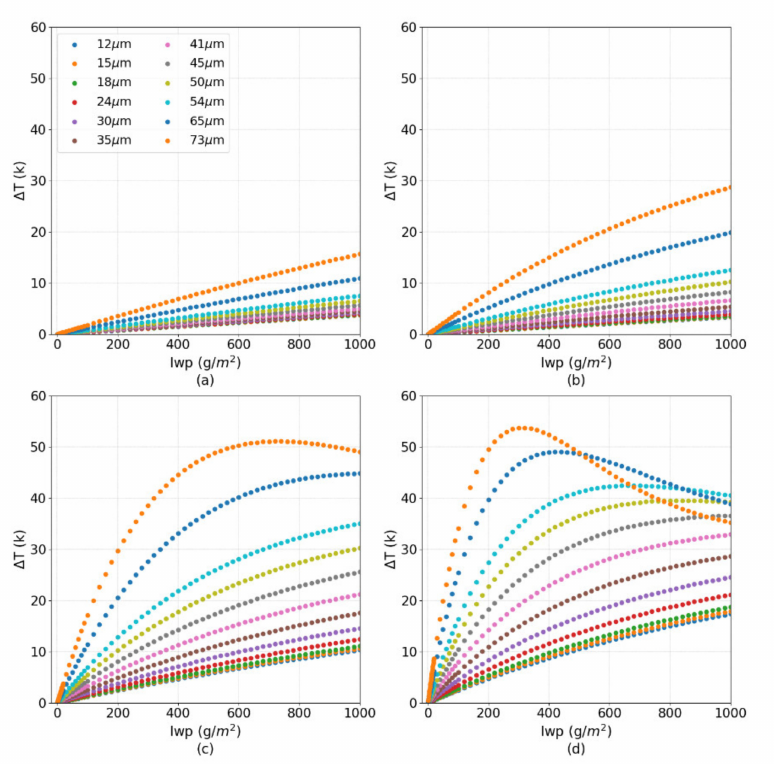
Figure 1. Simulated forward radiative transfer model. ( a ) 325.15 ± 9.5 GHz channel; ( b ) 448.0 ± 3.0 GHz channel; ( c ) 664.0 ± 4.2 GHz channel; ( d ) 874.4 ± 6.0